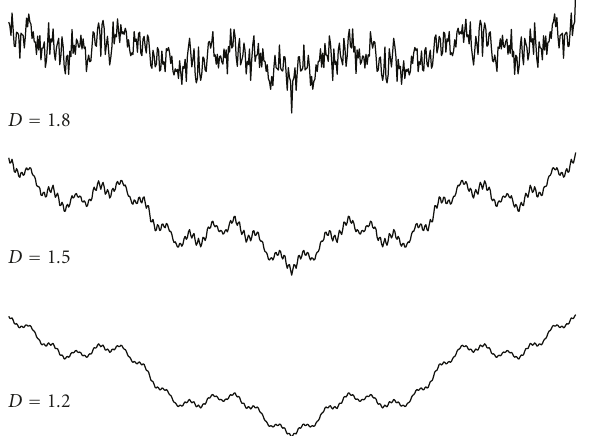
Figure 10: WCF generated signals with di ff erent FD.